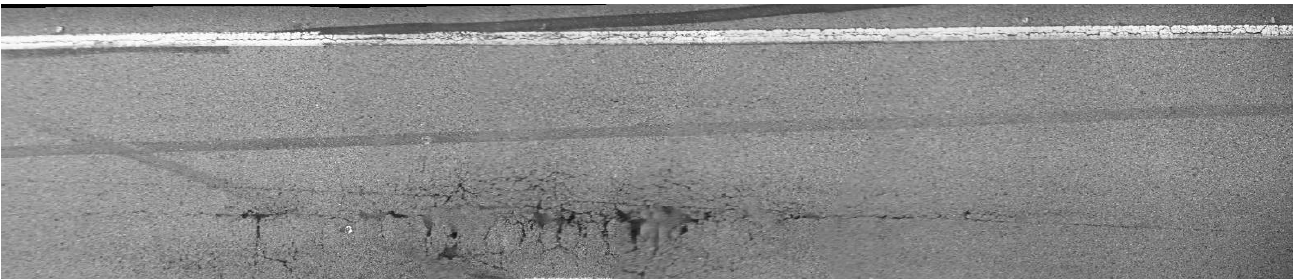
Figure 12. Illustration of the U-Net architecture proposed in [24].